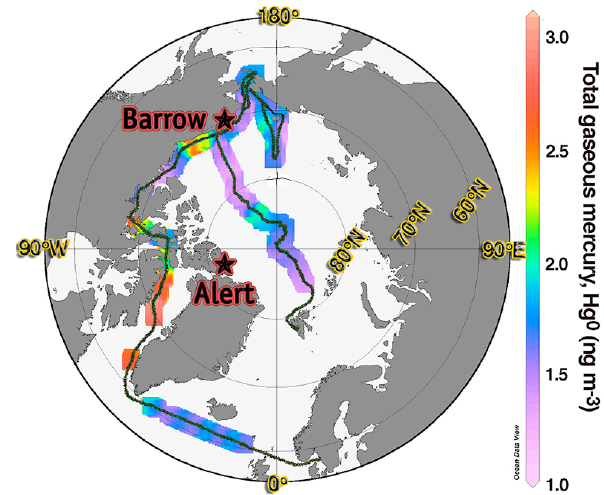
Figure 1 . The spatial distribution of TGM, Hg 0 in air (ng m -3 ) along the cruise track. The locations of coastal stations Alert (Nunavut, Canada) and Barrow (Alaska, USA) are included as well.